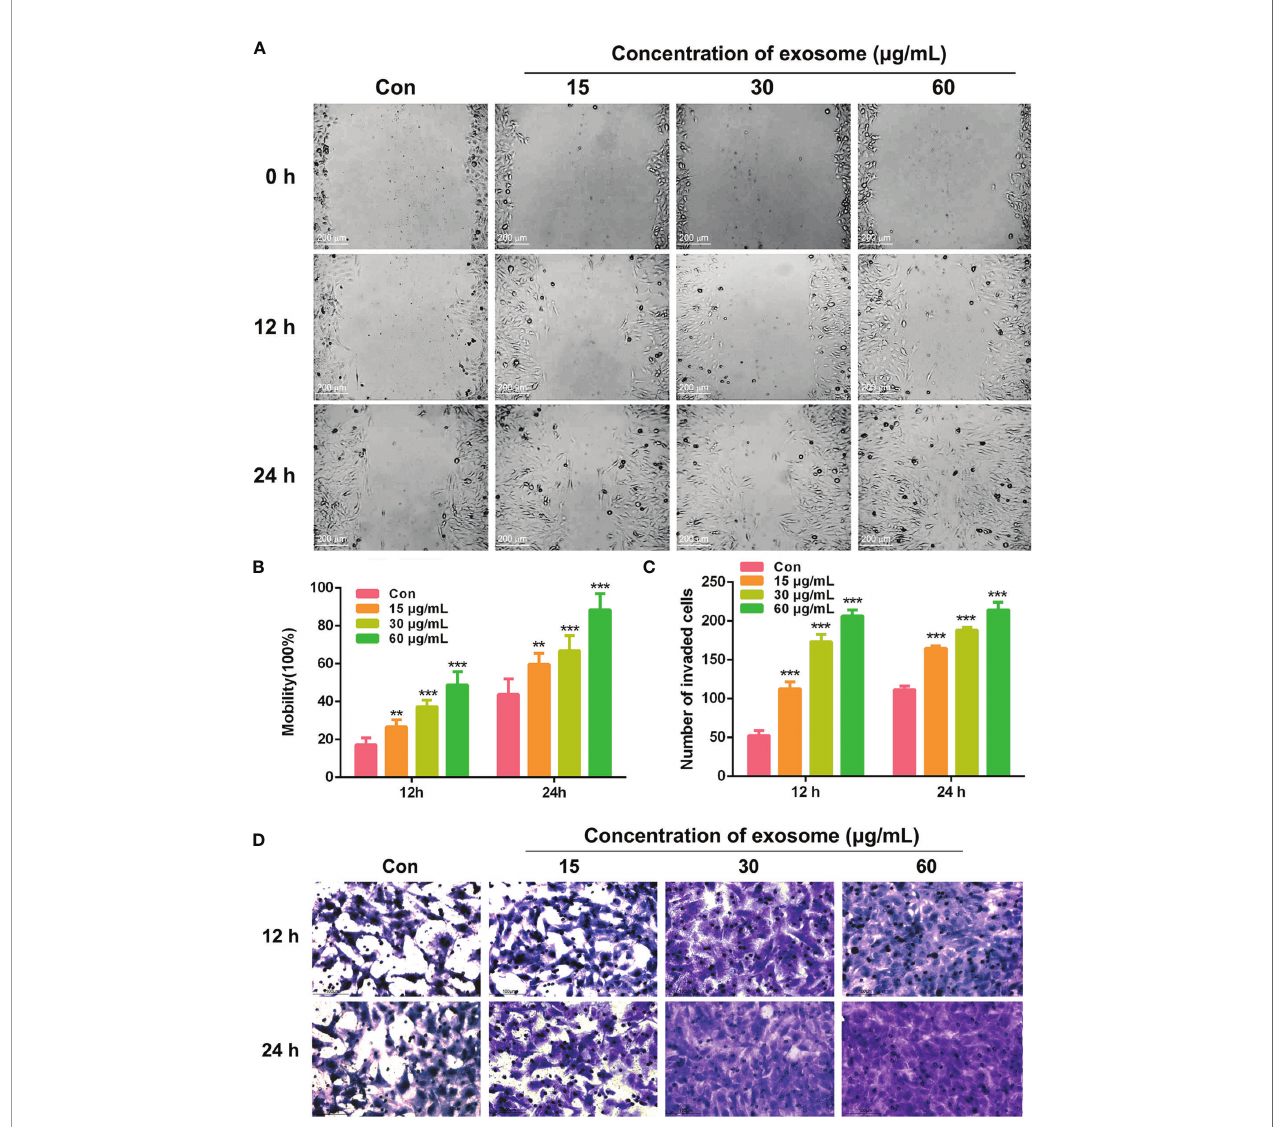
FIGURE 2 | The migration and invasion of BEAS-2B cells after treating with A549-cell-derived exosomes. (A) BEAS-2B cell migration induced by different concentrations (0, 15, 30, and 60 m g/ml) of A549-cell-derived exosomes at 0, 12, and 24 h is shown in the wound healing assay. Statistical analysis of scratch distance changes of (B) migration and cells number of (C) invasion; signi fi cant difference between treatment and control groups is indicated as ** p <0.01, *** p <0.001, and n ≥ 3. (D) BEAS-2B cells invasion induced by different concentrations (0, 15, 30, and 60 m g/ml) of A549-cell-derived exosomes at 12 and 24 h is shown in the invasion assay.